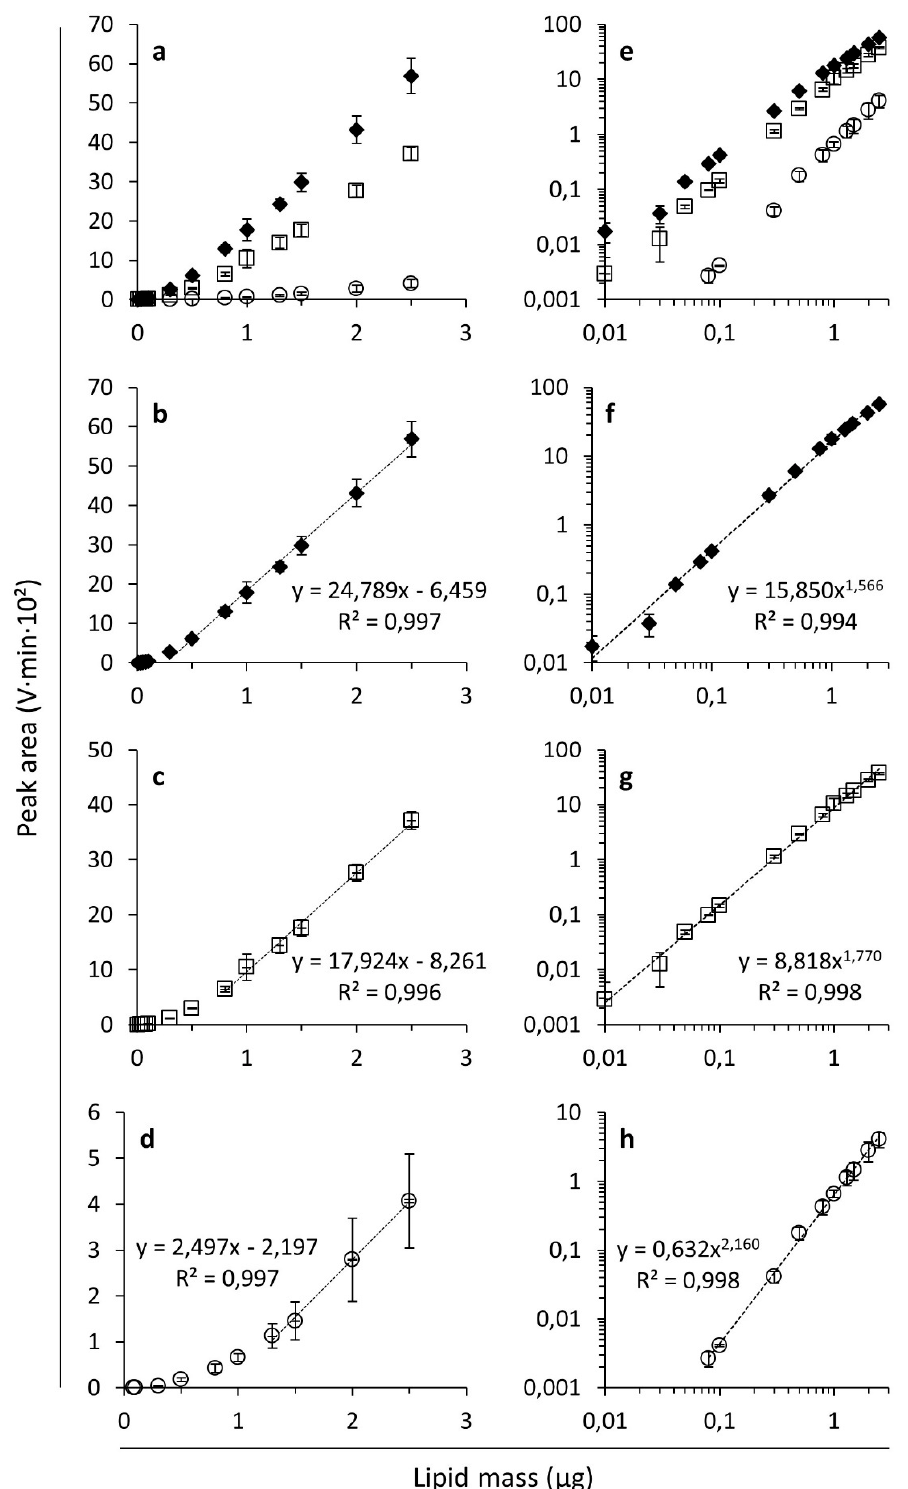
Figure 1. Evaporative light scattering detection responses expressed as peak areas (V · min · 10 2 ) as a function of the analyzed lipid mass ( µ g) for free fatty acids (FFAs ; linoleic acid), monoacylglycerols (MAGs ; monoolein) and diacylglycerols (DAGs ; 1,3-dilinolein) on linear ( a – d ) and logarithmic ( e – h ) scales. Average values with corresponding standard deviations of triplicate measurements are shown. Linear trend lines were fitted to the data in the range of linear response for FFAs ( b ), DAGs ( c ) and MAGs ( d ). Power trend lines were fitted to the data for FFAs ( f ), DAGs ( g ) and MAGs ( h ). The graphs show the corresponding trend line equations and R-squared values.